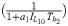
Effect of IL10—Th2 (IL4) synergy inhibition on Th1 cells.Simulation showing increased suppression of Th1 cells when there is IL-10—Th2 (IL4) synergy. Suppression of the Th1 response accompanied by loss of protection, increased disease progression and CFU shedding. Simulation of IL-10—Th2 (IL4) synergy were generated by a model with the assumption that IL-10 and IL-4 (Th2) interact synergistically to inhibit the expression of the Th1 responses. IL-10—Th2 (IL-4) synergy was modelled using the term, (11+a1IL10Th2), with a
1 = 0.005 while the rest of the model parameters are kept at their baseline values given in Table 2. The shading of cell populations before IL-10 inhibition are represented by the colours: grey-CFUs, blue-Th1 cells, red-bacteria, cyan-IL10, green-Th2 cells, pink-infected macrophages. The yellow shading represents the effect of IL-10 inhibition only, while the violet colour represents the effects of IL10 and IL4 synergy.